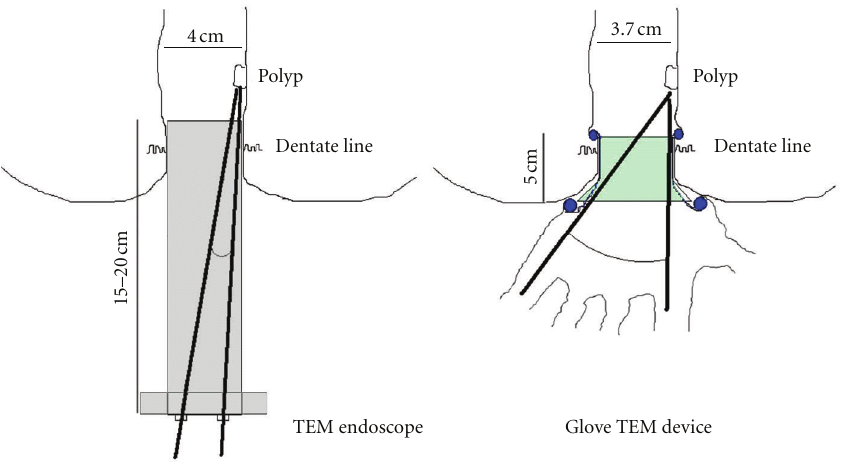
Figure 4: Traditional TEM endoscope versus Glove TEM device: dimensions and instruments working